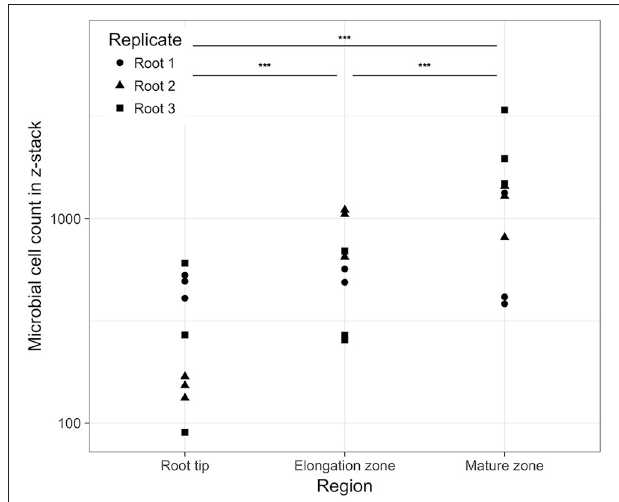
FIGURE 4 | Cell counts (log scale) in the observed image as a function of the position on the root. Horizontal bars above the data indicate significant differences ( P < 0.001) between